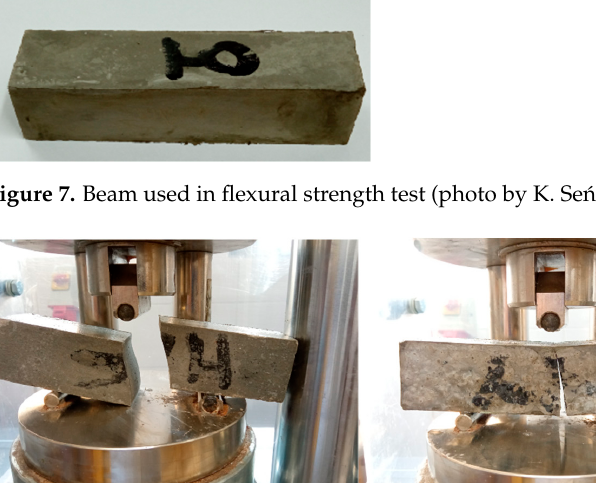
Figure 8. Samples used in compressive strength tests (photo by K. Se ń czuk).